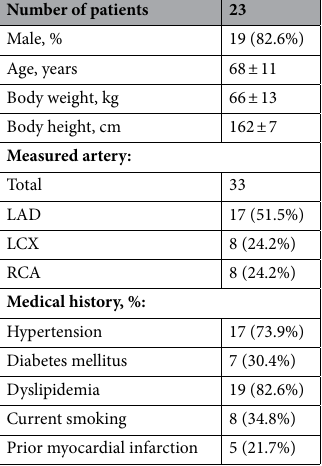
Table 1. Patients’ clinical characteristics. LAD left anterior descending artery, LCX left circumflex artery, RCA right coronary